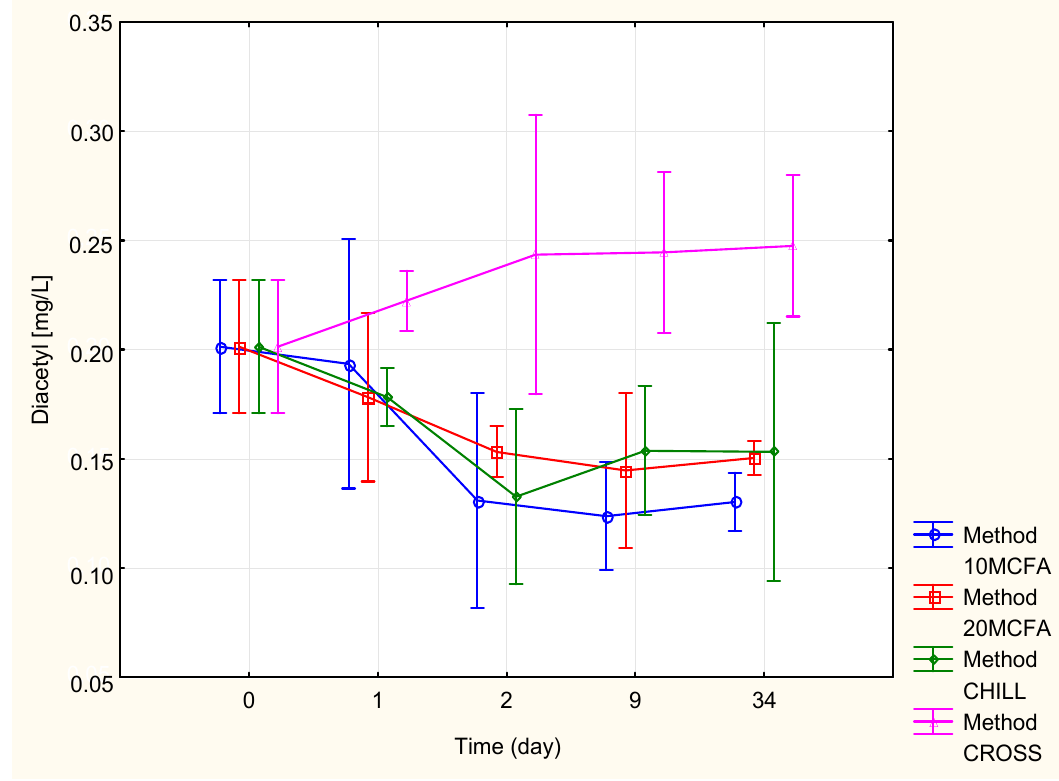
Figure 3. Changes in the diacetyl content. Table 4. Changes in diacetyl content. The average values ( n = 3) are supplemented by contribution into homogeneous groups (a, b, c, d) according to Fisher’s LSD (Least significant difference) test ( α = 0.05).